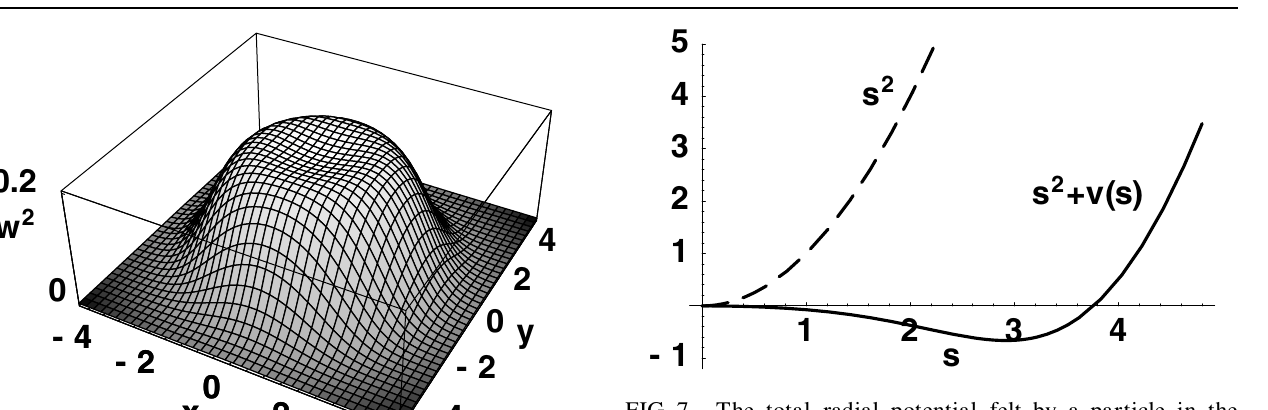
FIG. 7. The total radial potential felt by a particle in the beam compared with the harmonic potential (dashed line) for a space-charge strength of (cid:7) (cid:21) 22 : 5